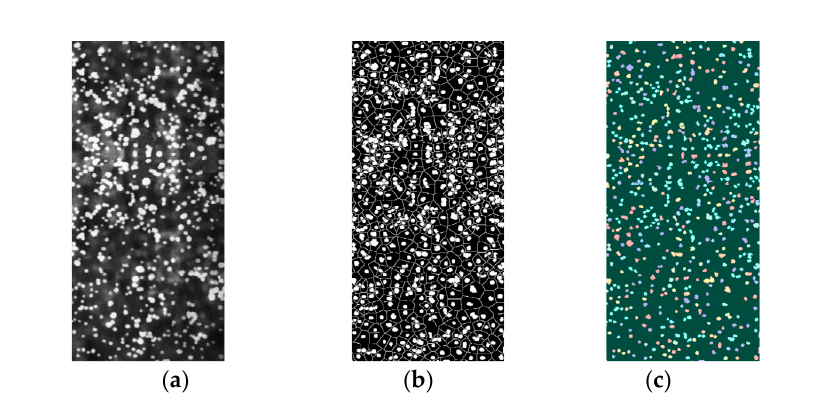
Figure 5. The effect of image segmentation. ( a ) Original gray image; ( b ) Markers and object boundaries image; ( c ) LRGB image.